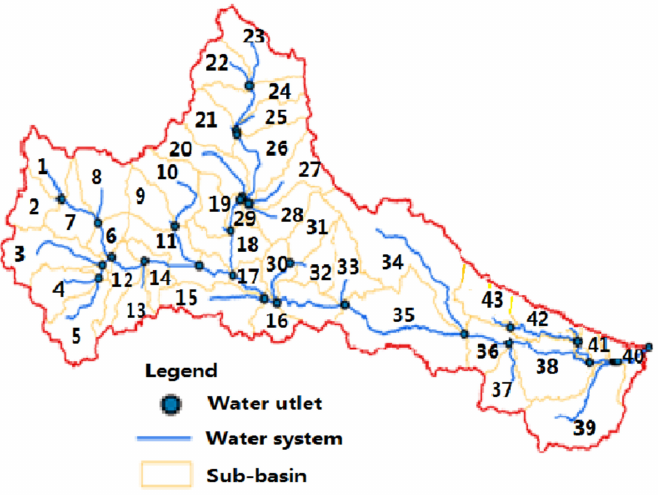
Figure 3. Sub-basin division of upper Weihe